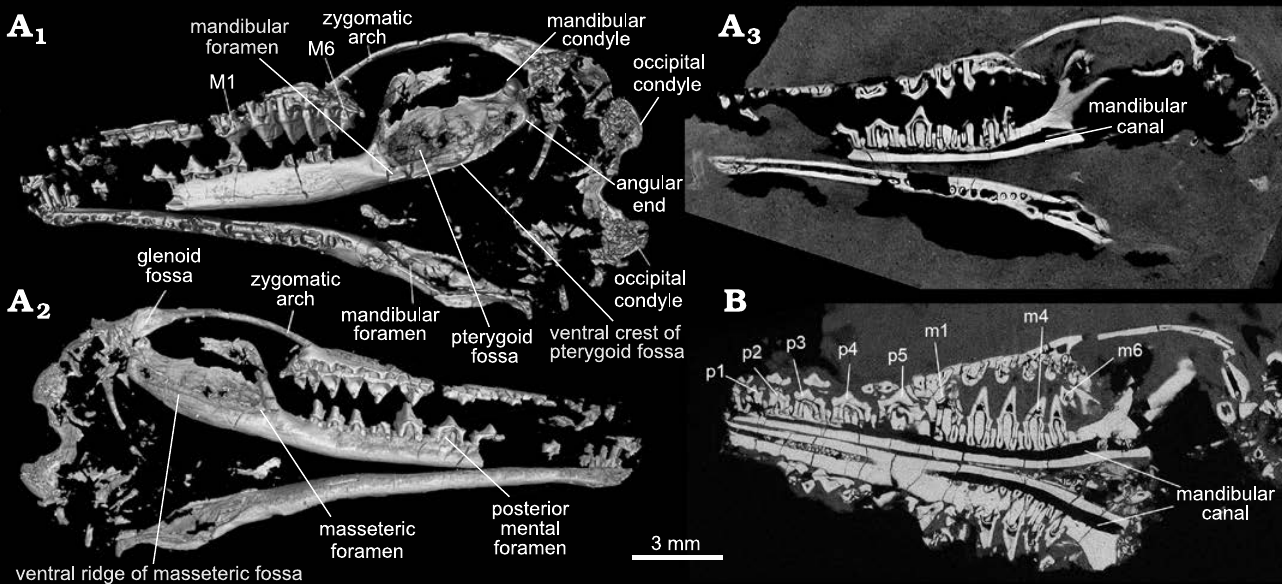
Fig. 2. CT-images of the trechnotherian mammal Lactodens sheni Han and Meng, 2016, from Aprian, Lower Cretaceous Jiufotang Formation, Caoyang City, Liaoning Province, China. A . Holotype (HG-M016) from Shangheshou area; A 1 , virtual skull remains with the lingual side of the right mandible exposed (see Han and Meng 2016: fig. 1); A 2 , virtual skull remains with the lateral side of the right mandible exposed (this side of the skull is embeded in the matrix and not visible except for the part of cheek teeth that were needle-prepared from the back side of the slab (Han and Meng 2016: figs. 1, 5); A 3 , a CT-slice showing the contrast of bone and matrix and revealing the roots of some teeth. B . ZGY0053 from Dapingfang, a CT-section through the skull (showing the root conditions). Note there is no tooth germ under any cheek teeth in both specimens in A 3 and Table 1. Measurements (in mm length/width and angular degree of the were taken using digital methods from the CT images of trigon and trigonid) of the teeth of Lactodens sheni Han and Meng, the specimen. Linear measurements were taken using the 2016 (ZGY0053). *, estimated; ?, unknown. Teeth Left Right